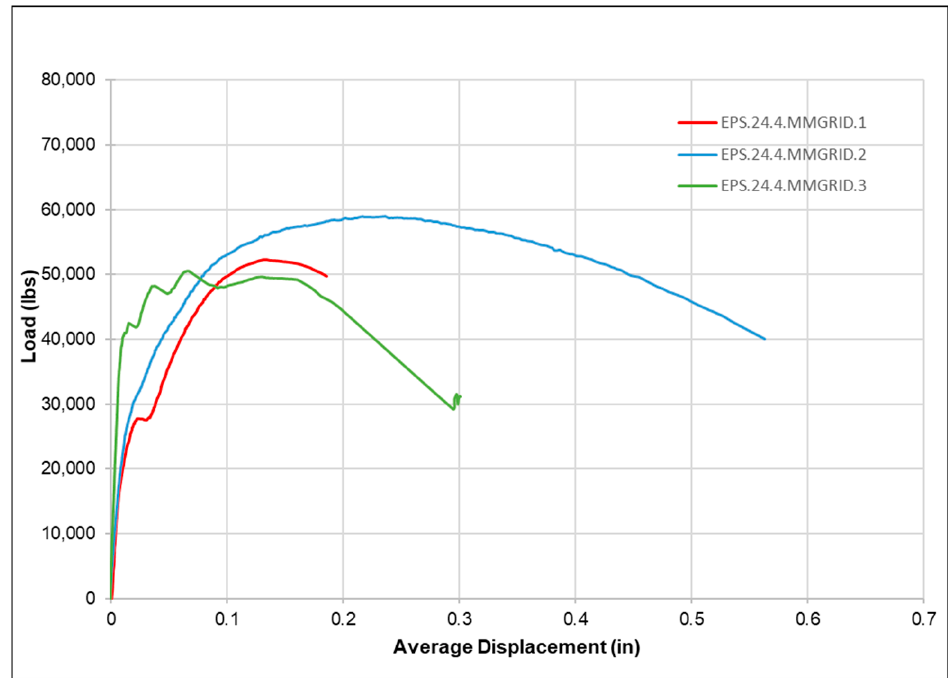
Figure 16. Average displacement behavior for each of the three specimens having 4 in (102 mm) EPS.